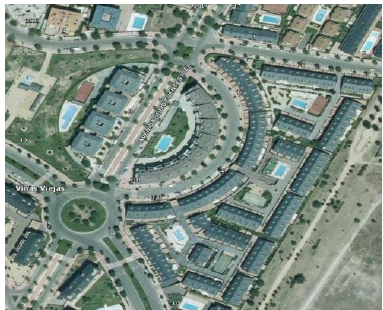
Figure 9. Geographic projection 42º North